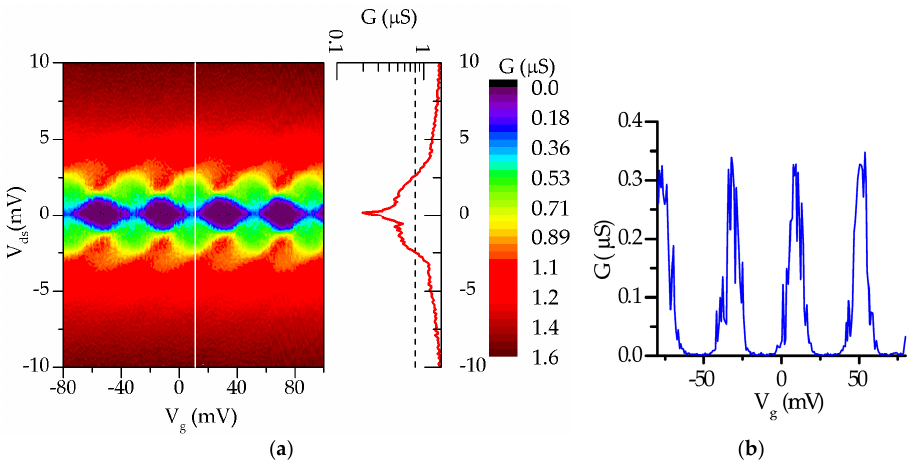
Figure 12. ( a ) Coulomb charging diagram and G ( V ds ) cross section at V g = 10 mV of a Ni ‐ SiO 2 ‐ Ni device fabricated with two RHP steps (measured at T = 0.4 K). Barrier composition is 12 cycles (~1 nm) of SiO 2 by plasma ‐ enhanced ALD (PEALD); ( b ) CBOs of the same device.